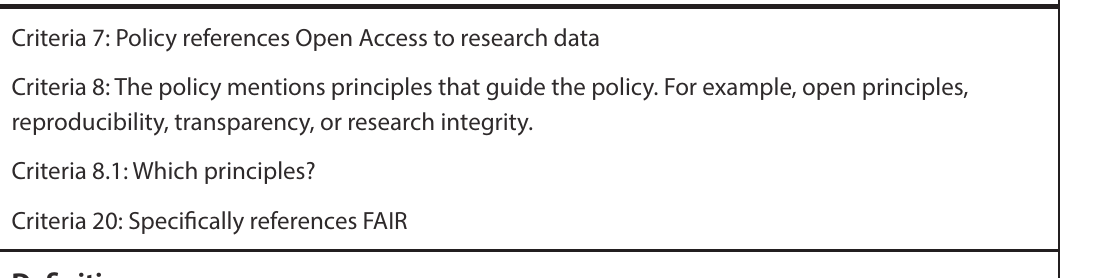
Table 1 : Subset of criteria reported in this article. See the complete list of criteria in Appendix A. Guiding